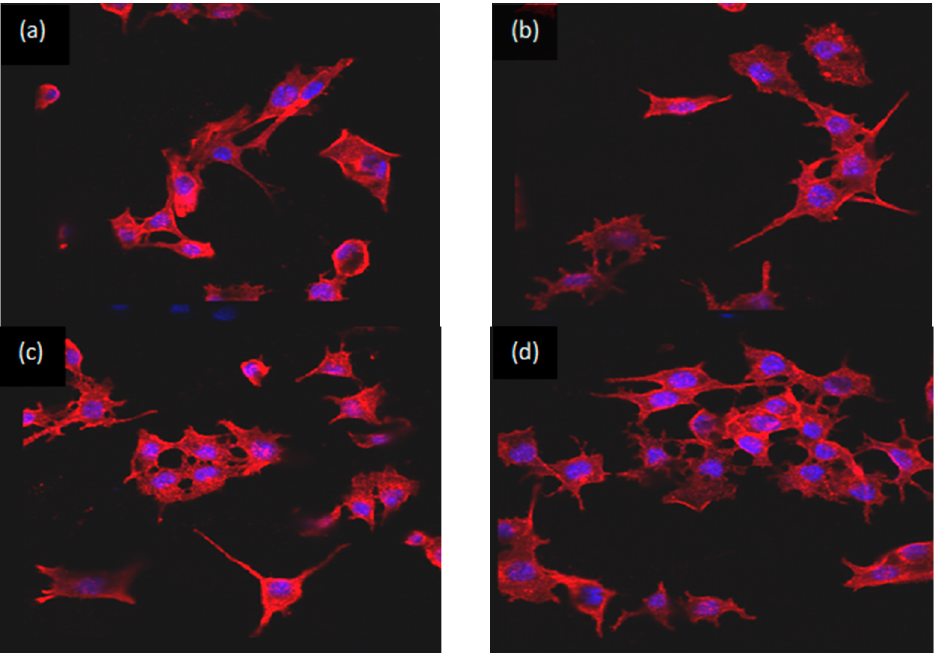
Figure 8. Images of the laser confocal microscopy experiment of BMPC samples. ( a ) BMPC0; ( b ) BMPC2; ( c ) BMPC40; ( d ) BMPC60.